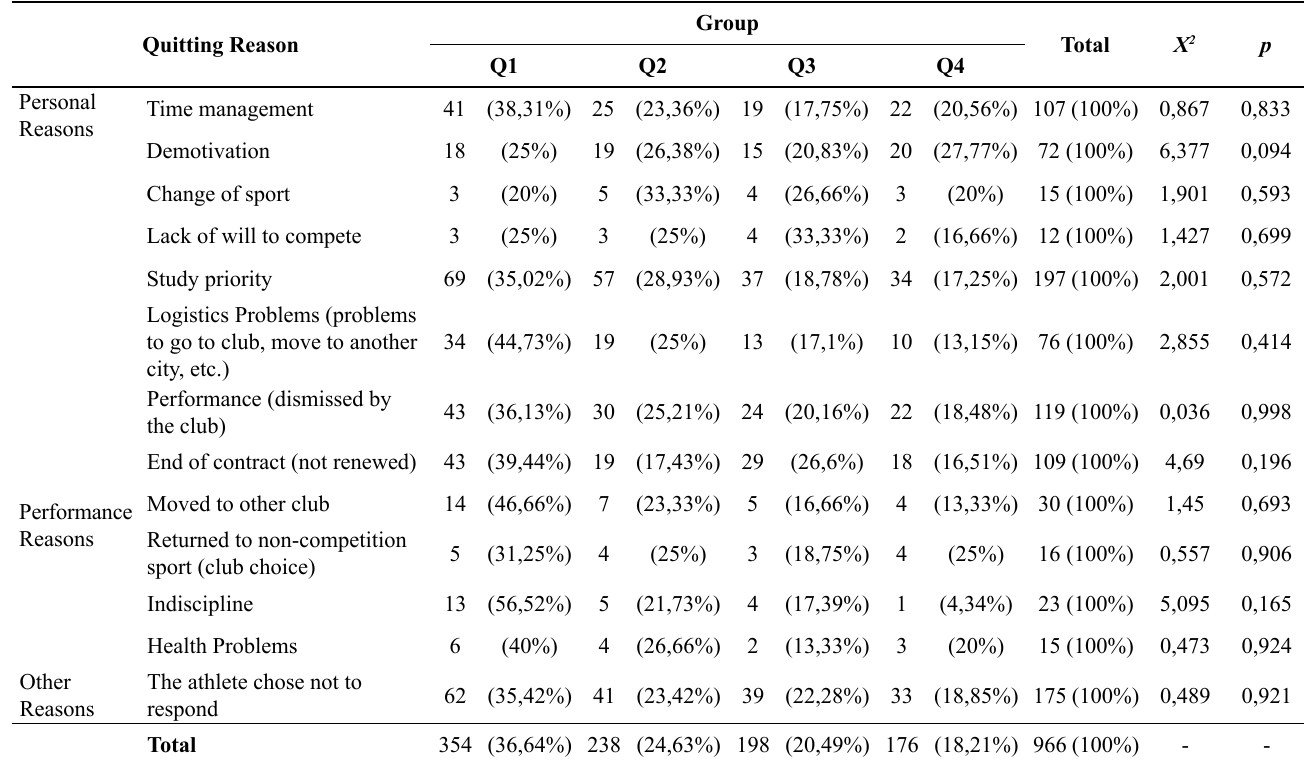
Table 2. Reason for disengagement from competitive sport Quitting